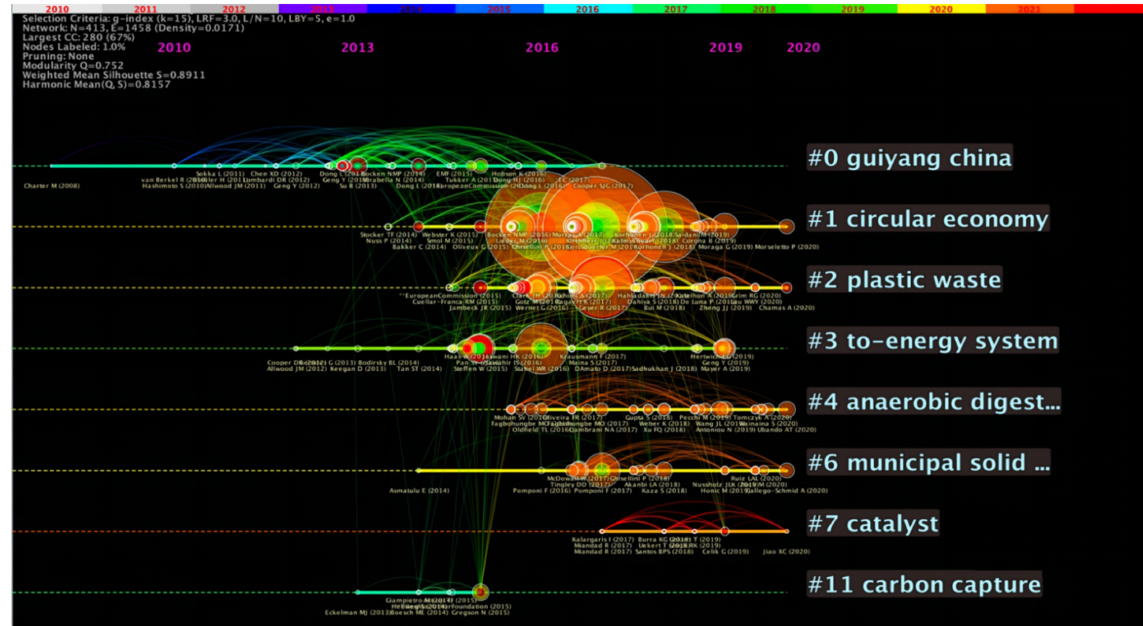
Figure 8. Timeline view of the co-cited